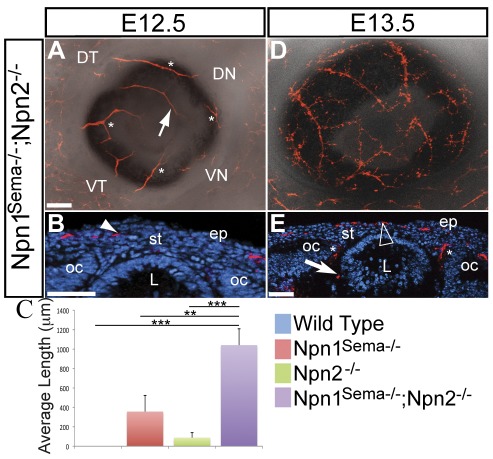
Increased disruption of corneal innervation in Npn1Sema−/−;Npn2−/− double mutants.Whole mount and sections of E12.5–E13.5 eyes were immunostained with TuJ1. Sections were counter stained with DAPI. (A–B) Several nerve bundles projected into ectopic regions of the anterior eye (asterisks), the dorsal temporal region (arrow) and presumptive stroma (arrowhead) are prematurely innervated. (C) Quantification of axon lengths at E12.5 showed that more nerve bundles innervated the Npn1Sema−/−;Npn2−/− double mutant cornea than Npn1Sema−/− or Npn2−/− alone. The quantification method is described in the Methods section. No bracket indicates a relationship of P>0.05; **, P<0.01; ***, P<0.001. (D–E) By E13.5, several nerve bundles project towards the central cornea. The presumptive corneal epithelium is innervated (arrowhead), and some nerve bundles project into ectopic regions near the lens vesicle (arrow) and between the lens and optic cup (asterisks). Scale bar: 100 µm. oc, optic cup; c, cornea.